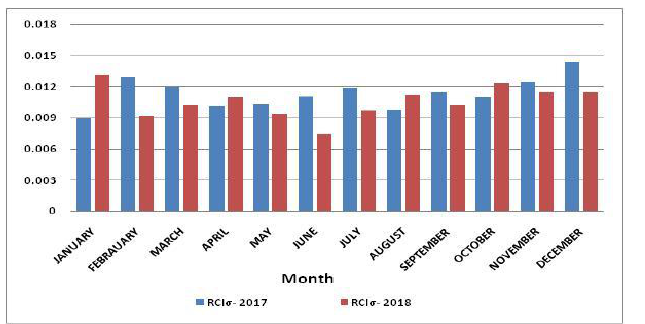
Figure 34. Comparison between maximum values of downward power ramps in 15 min interval for each month for years 2017 and 2018.